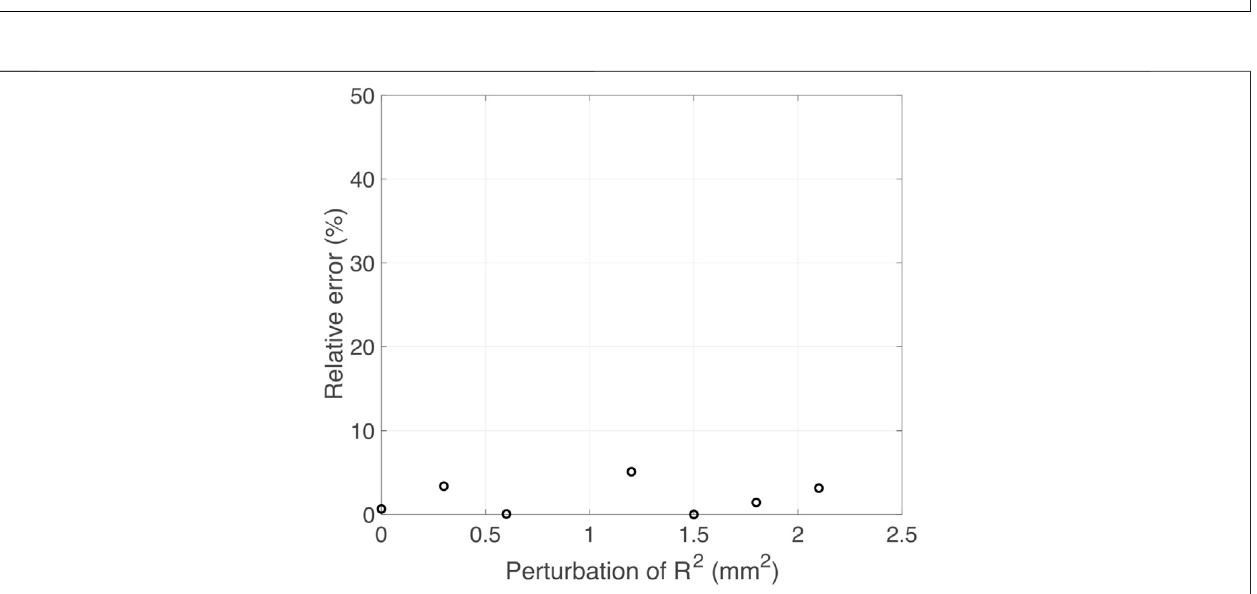
FIGURE A-2 | The Relative error between C 11 and C 22